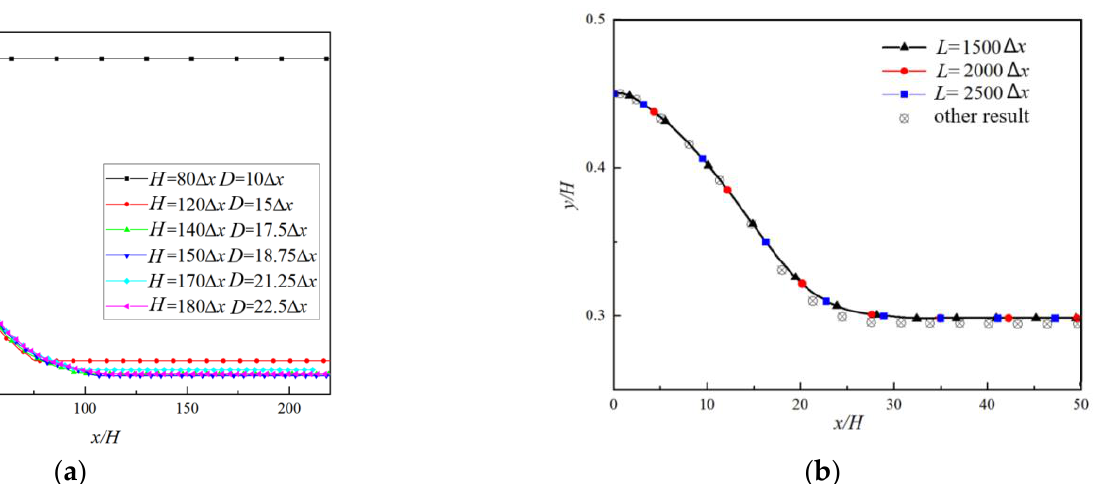
ent n . For the case of β =0.5 (i.e., the small particle is downstream) as shown in Figure 6a(the time to reach a steady state is 18,000s), l / D increases rapidly at first, and then slowly and linearly in Newtonian fluid ( n =1).The case is the same as Newtonian fluid in shear-thickening fluid ( n =1.2), but the growth rate is greater for the latter. For shear- thinning fluid ( n =0.8), the case is completely different, l / D increases rapidly at first and then decreases slowly, finally approaching a constant, indicating that the particle spac- ing can reach a stable state finally. ( a ) ( b ) Figure 6. Changes of l/D along flow direction for different n ( Re =20). ( a ) β =0.5, ( b ) β =1.2. For the case of β =1.2 (i.e., the large particle is downstream) as shown in Figure 6b(the time to reach a steady-state is 21,600s), l / D increases rapidly at first, then slowly and linearly in shear-thinning fluid, but l / D increases rapidly at first and then decreases in the shear-thickening fluid. In a Newtonian fluid, l / D increases rapidly at first and then decreases slowly, finally approaching a constant, and the particle spacing can reach a stable state finally. Therefore, the effect of fluid property on the particle spacing in the steady state is obvious.